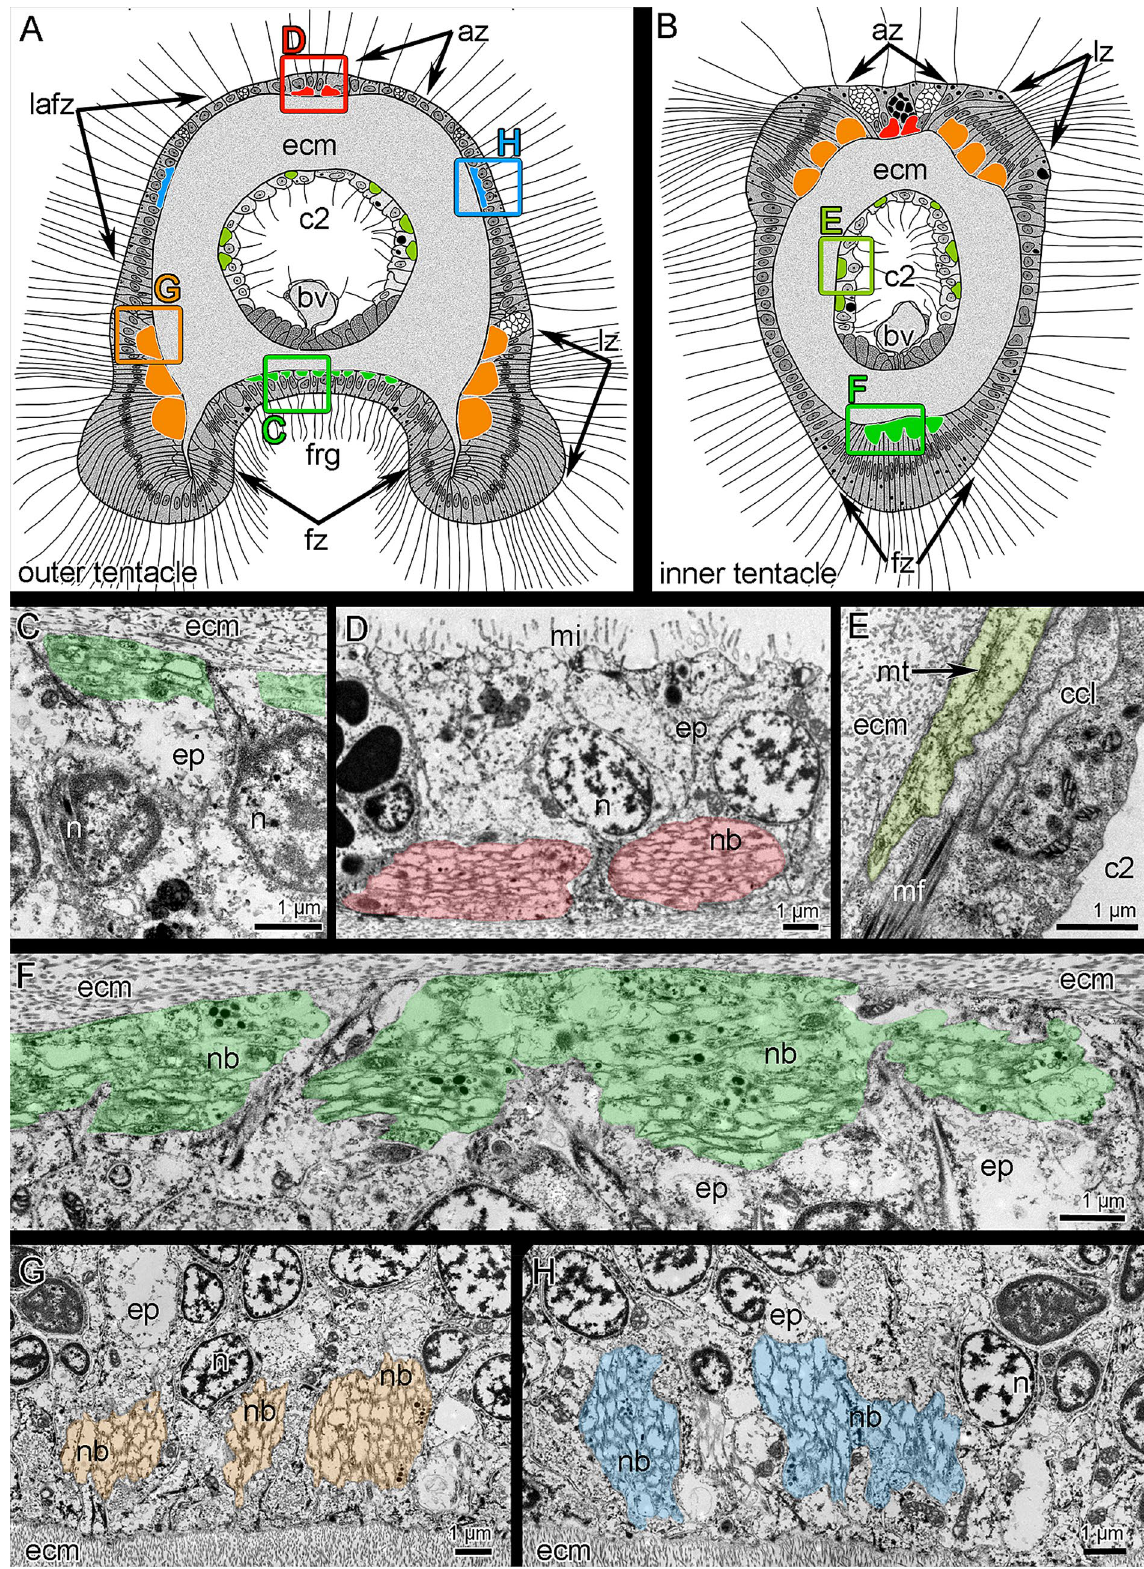
Figure 5. Innervation of tentacles of Coptothyris grayi . Schemes of cross section ( A – B )—colored boxes and letters indicate places, which ultrastructure is given in the figure; TEM ( C – H ). ( A ) Organization of the outer tentacle. ( B ) Organization of the inner tentacle. ( C ) Frontal neurite bundle of outer tentacle. ( D ) Abfrontal neurite bundle of outer tentacle. ( E ) Peritoneal neurite of inner tentacle. ( F ) A portion of frontal nerve of inner tentacle. ( G ) Lateral tentacle nerve of outer tentacle. ( H ) Lateroabfrontal nerve of outer tentacle. Abbreviations: az—abfrontal zone; bv—tentacle blood vessel; c2—tentacle coelom (mesocoel); ccl—cells of coelomic lining; ecm—extracellular matrix; ep—epithelium; frg—frontal groove; fz—frontal zone; lafz—lateroabfrontal zone; lz—lateral zone; mf— myofilaments; mi—microvilli; mt—microtubule; n—nucleus; nb—neurite